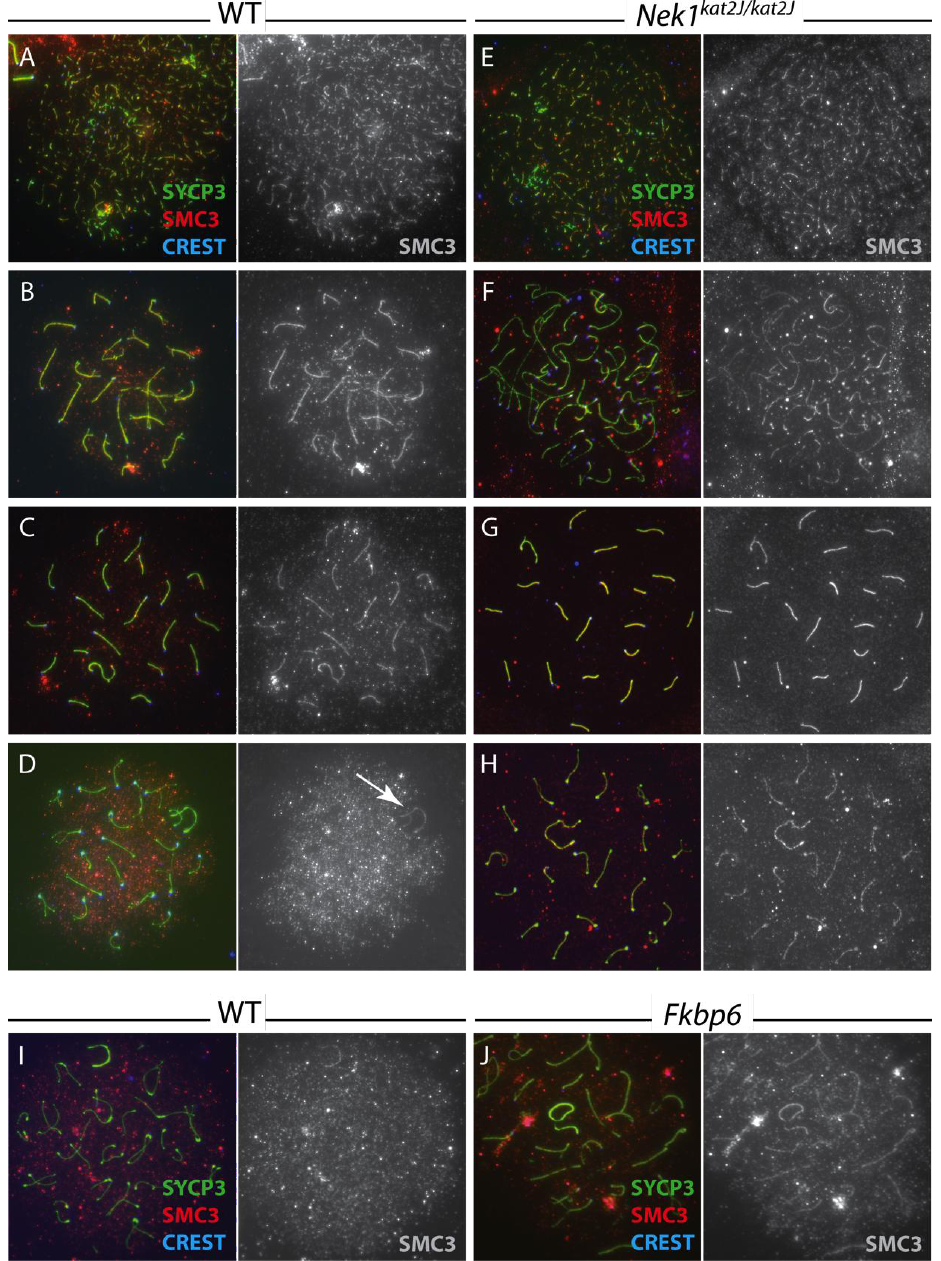
Figure 7. Cohesin protein SMC3 is not removed in the proper temporal manner in Nek1 kat2J/kat2J spermatocytes. Wild type (A–D) and Nek1 kat2J/kat2J (E–H) spermatocytes were stained with anti-SYCP3 (green), anti-SMC3 (red) and CREST autoimmune serum (blue). Cells in leptonema (A, E), zygonema (B, F), pachynema (C, G) and diplonema (D, H) were assessed for SMC3 localization (gray panels show SMC3 staining alone). The persistent XY chromosome staining of SMC3 in wild type cells is shown by the arrow. Wild type (I) and Fkbp6 −/− (J) spermatocytes were also stained with anti-SYCP3 (green), anti-SMC3 (red) and CREST autoimmune serum (blue), however only the diplotene stage is shown